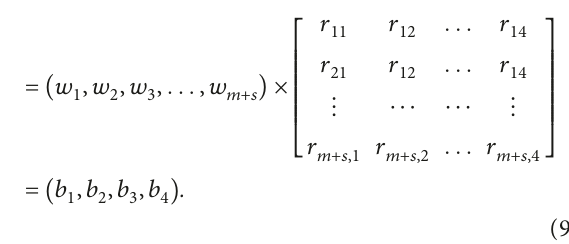
Figure 2: Regional distribution mapping of the surveyed